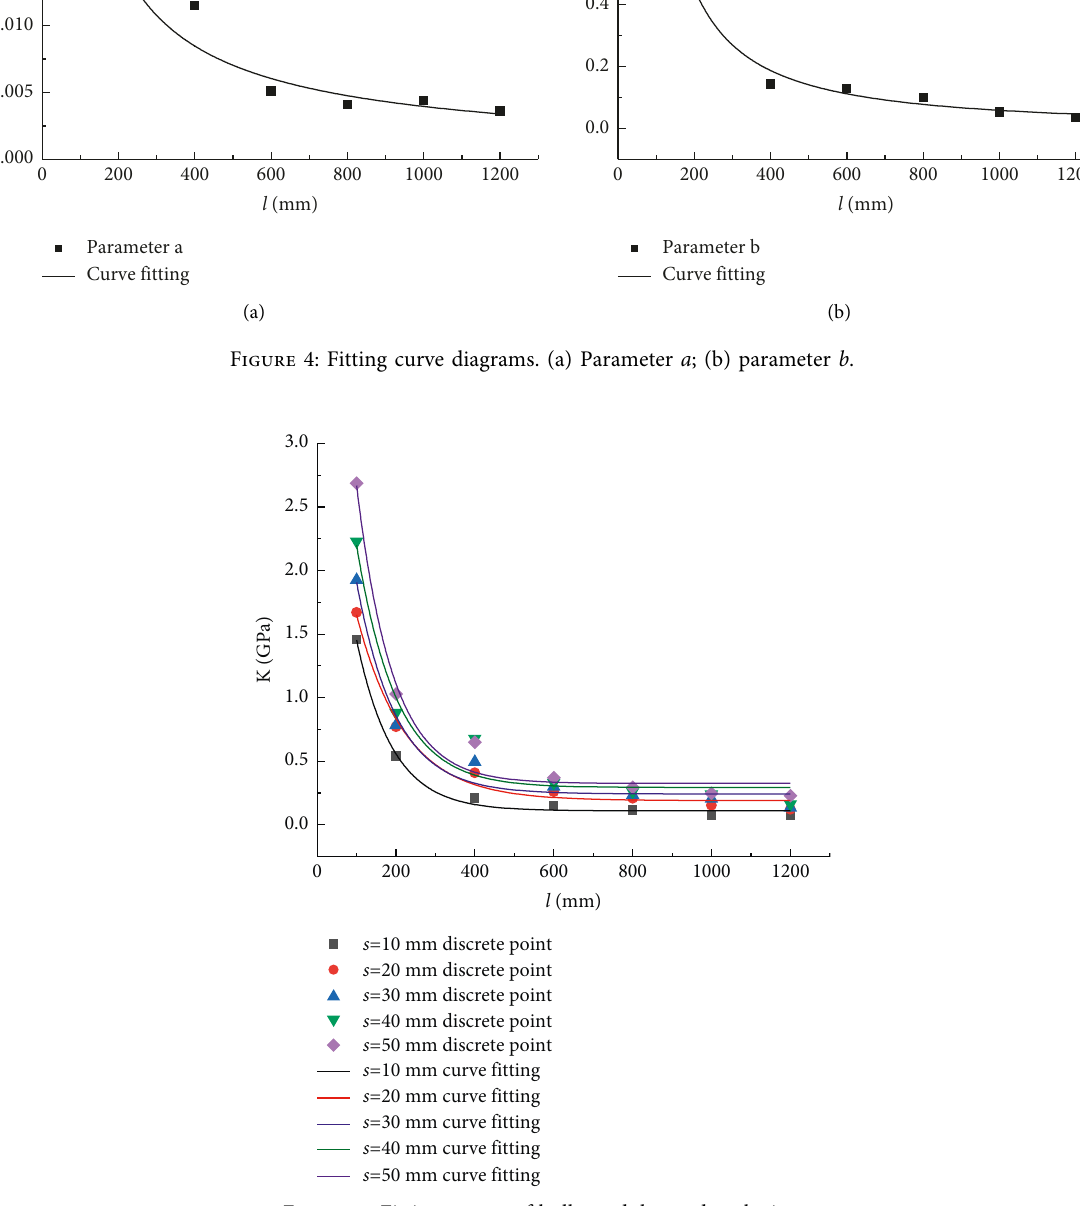
Figure 5: Fitting curves of bulk modulus and rock